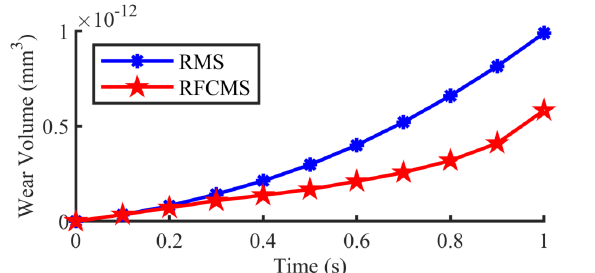
Figure 7. Curve of wear volume over